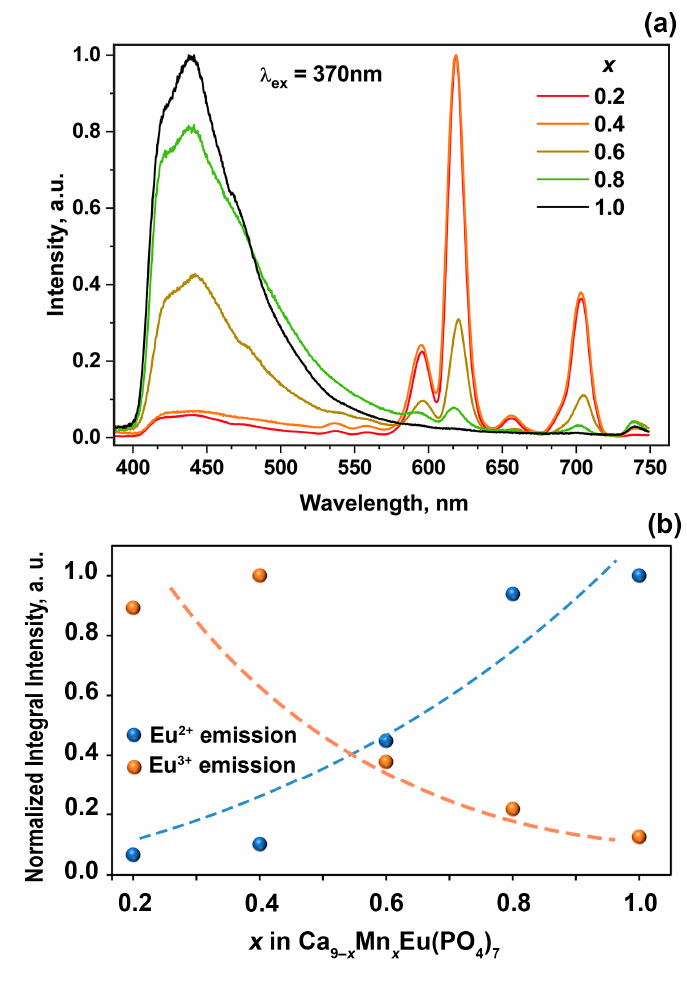
Figure 14. ( a ) PL spectra for Ca 9 − x Mn x Eu(PO 4 ) 7 at λ ex = 370 nm; ( b ) the dependence of normalized integral intensity of Eu 2+ and Eu 3+ emission ( λ ex = 370 nm).